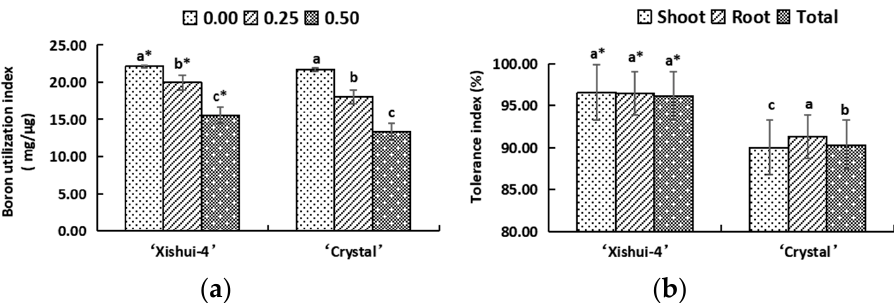
Figure 7. Effects of B-deficiency on adaptability difference of two grape genotypes: ( a ) utilization index; ( b ) tolerance index. Different lowercase letters within each column are significantly different at p < 0.05 between treatments. * is significantly different at p < 0.05 between genotypes.